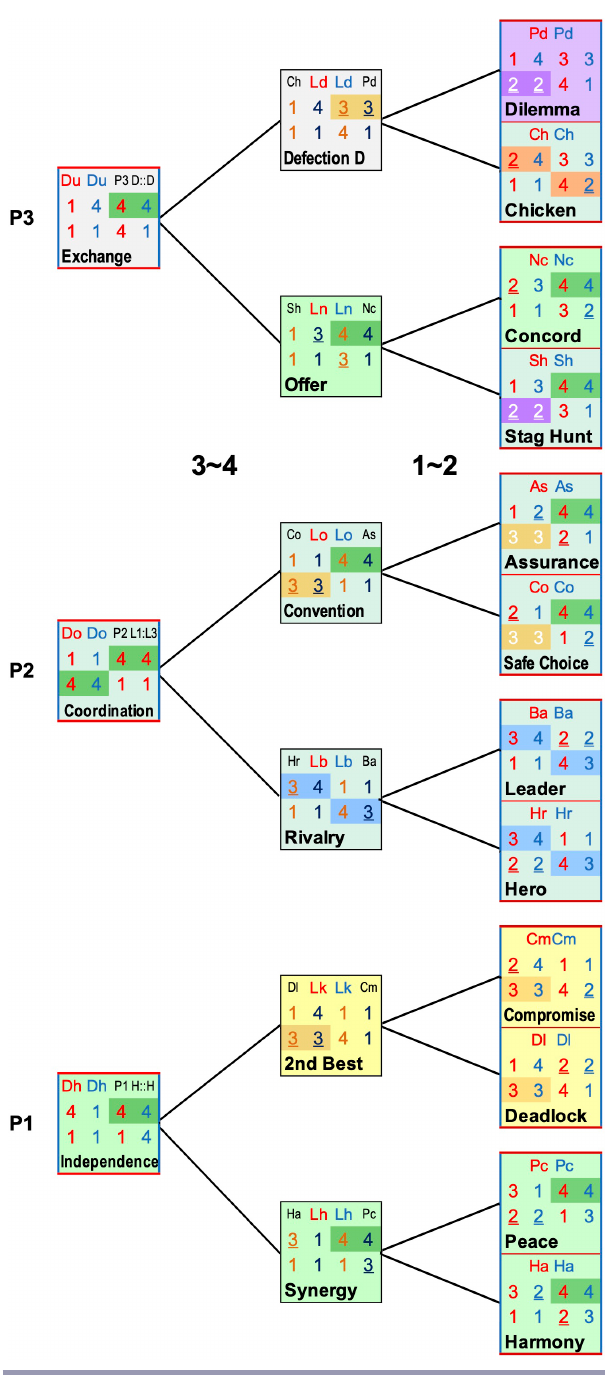
Fig. 3. Primal archetypes generate diverse games. Breaking high ties and low ties differentiates the three symmetric primal archetypes into families of games with two equally ranked outcomes (ties) for each actor and into the 12 strict symmetric ordinal games, with four ranked payoffs and no ties. Moving from left to right, payoffs from breaking ties are